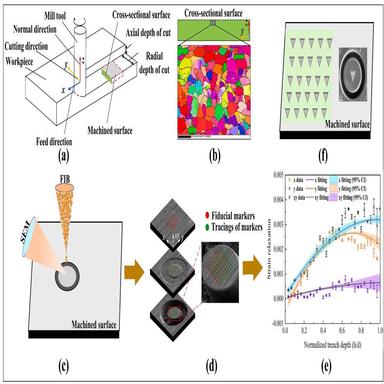
Schematic illustration of multiscale characterization process used in this work. (a) The schematic diagram illustrates the locations of machined surface samples. (b) Schematic of the location for the characterization of the microstructure by EBSD. (c) Schematic illustration depicting the process of acquiring SEM images and FIB incremental milling. (d) Illustration of the displacement tracking of the ring core during the stress relaxation during incremental milling. (e) The strain relaxation profiles achieve